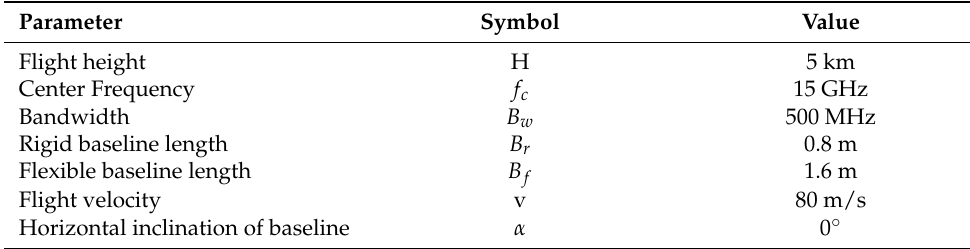
Table 1. The parameters of airborne array flexible